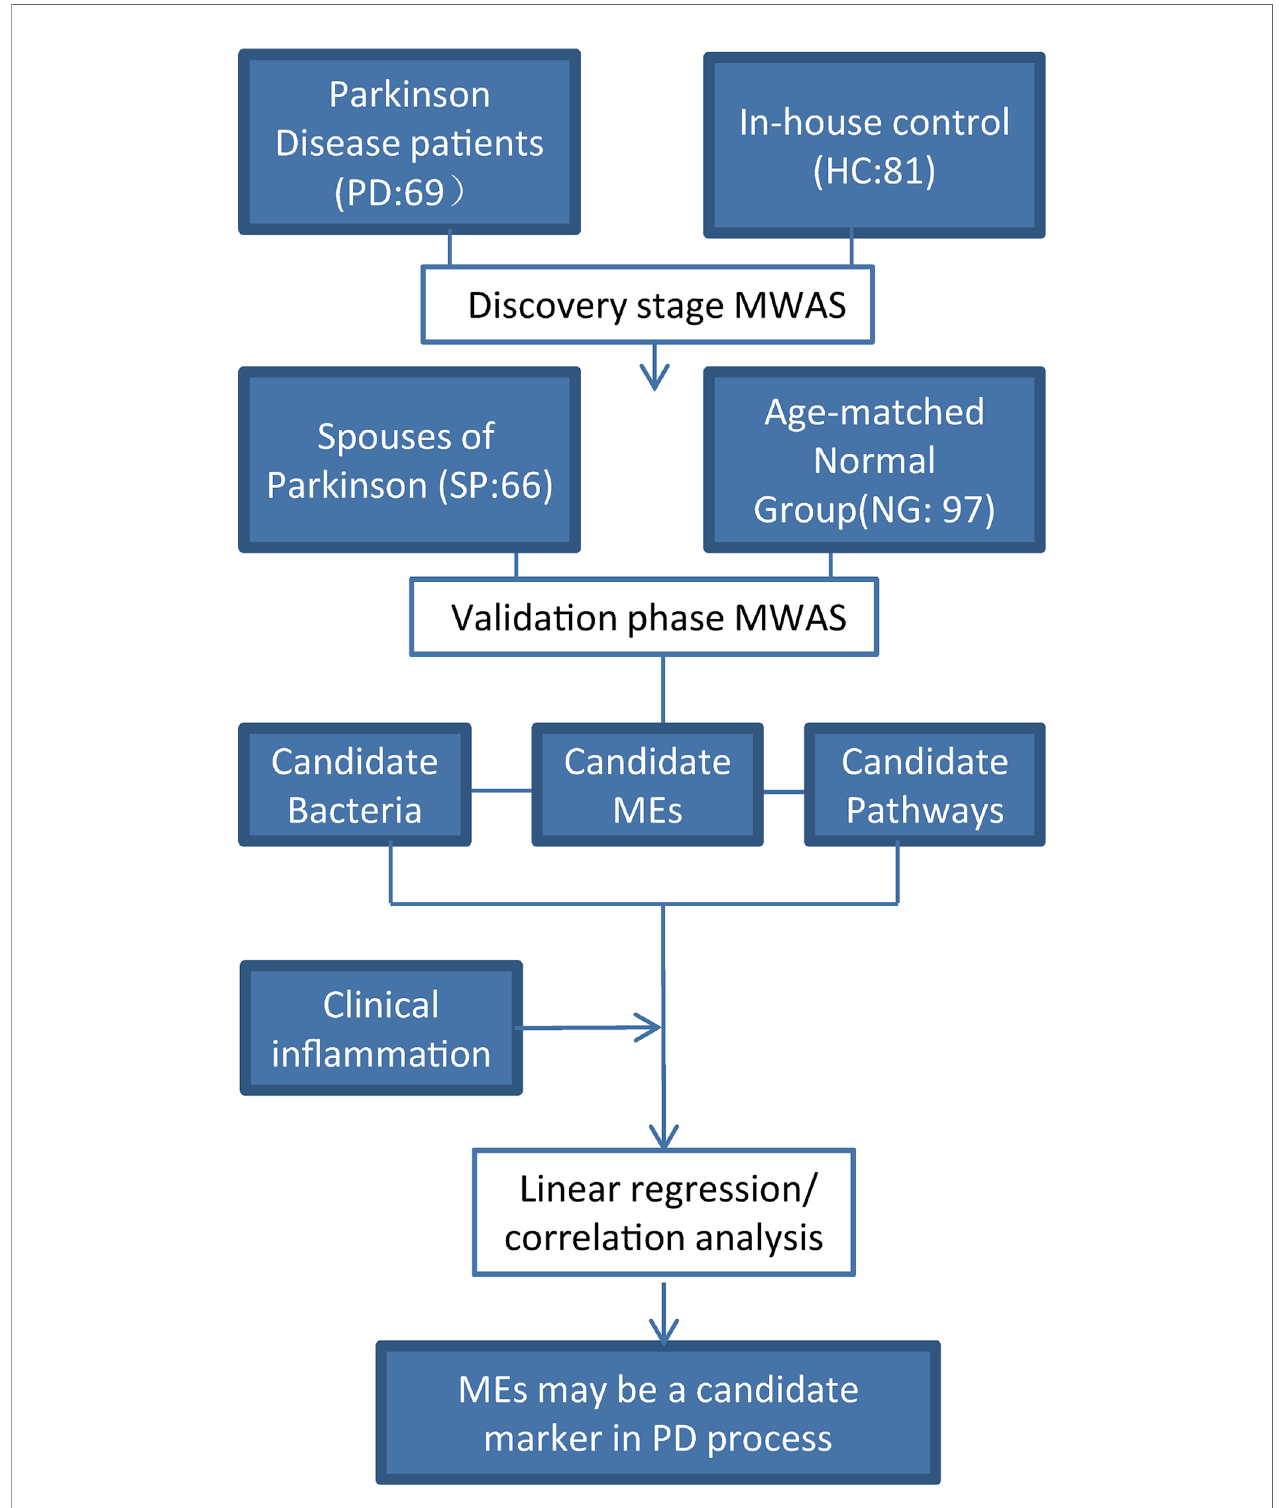
FIGURE 1 | Study design. A two-stage (discovery and validate) MWAS analysis as used to identify potential bacterial biomarkers for PD. PD, Parkinson ’ s disease; SP, spouse of PD patients; NG, normal group; HC, healthy control. The SP group was used to account for the in fl uence of lifestyle and dietary factors. The NG group was used to evaluate the effects of age and gender. Robust bacteria/epitope/pathway biomarkers were identi fi ed and their correlations with clinical parameters were evaluated.